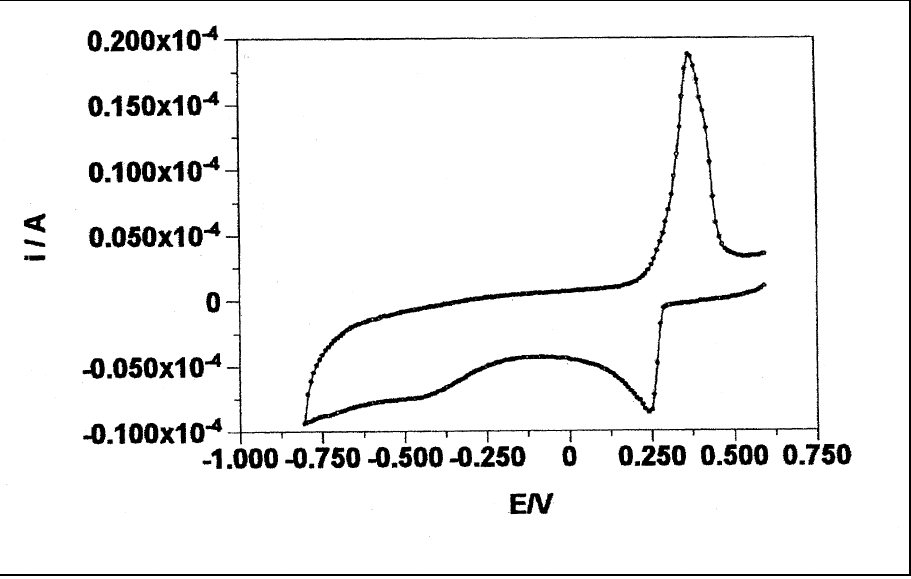
Figure A. Electrochemical behavior of the silver cation.